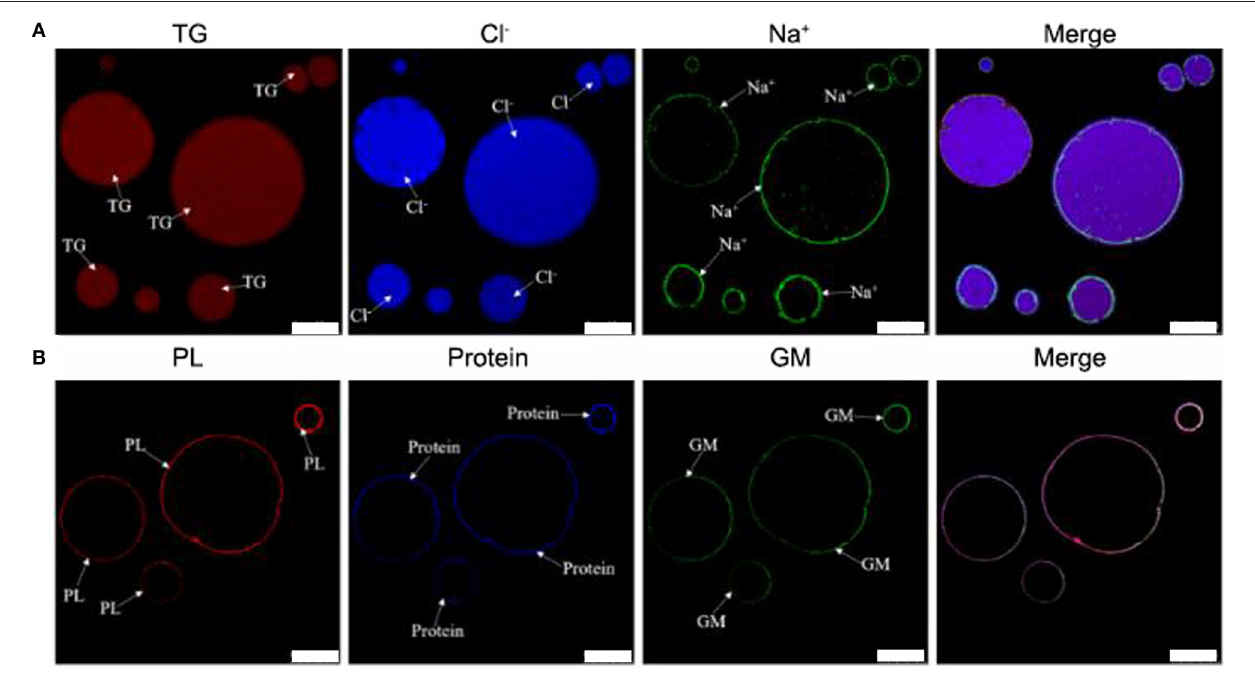
FIGURE 1 | LSCM images of TCPs in tuna head soup at 150min boiling time. (A) Nile Red, MQAE, and CoroNa TM Green were used to stain the triglycerides (TG), chloride ions (Cl − ), and sodium ions (Na + ), respectively. (B) Rd-DOPE, Nile Blue, and WGA488 were used to stain the phospholipids (PL), proteins, and glycosyl molecules (GM), respectively. White scale bars indicate 10 µ